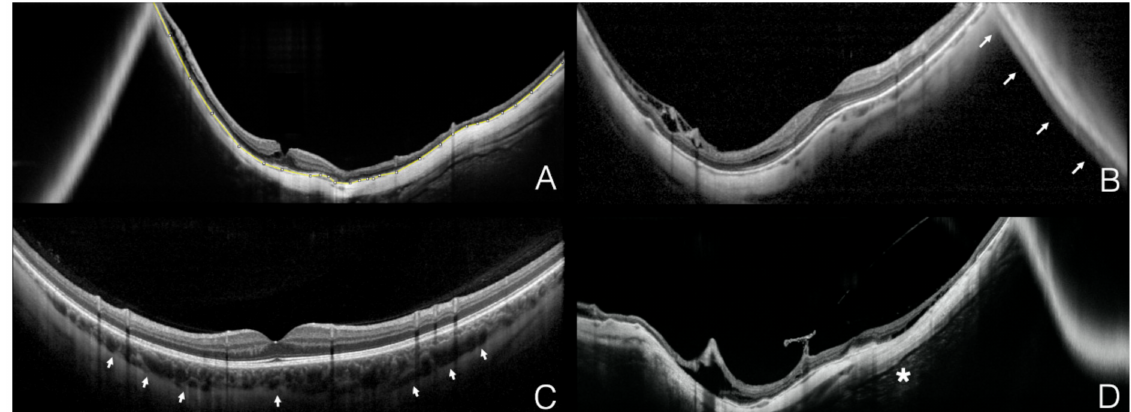
Figure 1. Representative examples of the different qualitative and quantitative parameters analyzed on the optical coherence tomography B-scans. The yellow segmented line (ImageJ measurement tool) delineates the total measurable retinal pigment epithelium in the B-scan ( A ). The white arrows denote the conjugate image artifact ( B ). The white arrowheads delineate the sclerochoroidal interface ( C ). The white asterisk marks the retrobulbar tissue as reflective structures detectable posterior to the sclera ( D